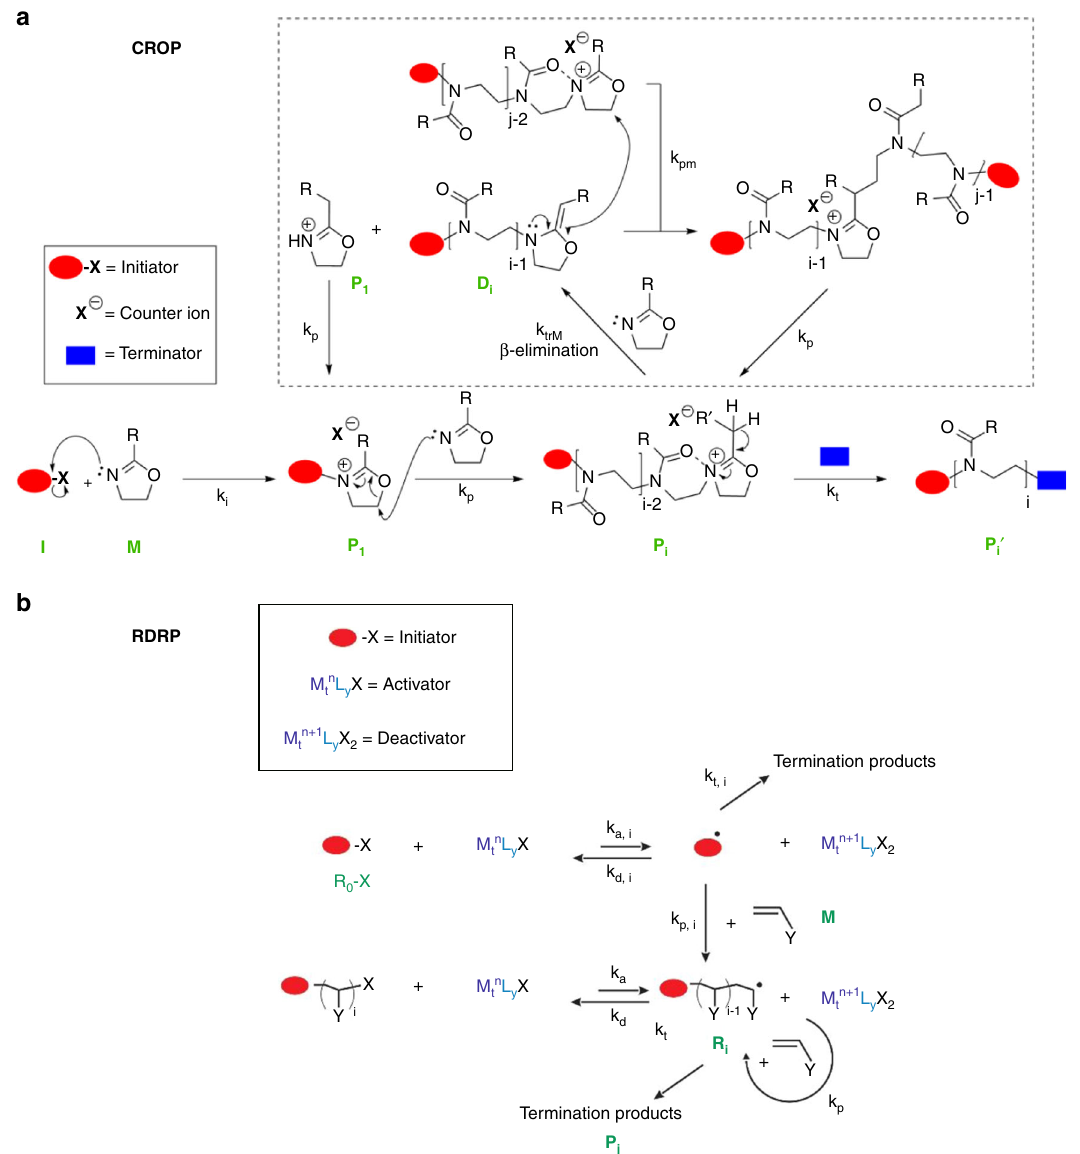
Fig. 1 Principle of cationic ring opening and reversible deactivation radical polymerization. a reactions for cationic ring opening polymerization (CROP) of 2- oxazolines (M) with initiator I; k i,p,t,trM,pm : rate coef fi cient of chain initiation leading to formation of P 1 , propagation leading to formation of P i (i: chain length; i > 1), termination leading to formation of P i ’ , β -elimination leading to formation of macromonomer D i , and macropropagation leading to formation of mid- chain cationic macrospecies with further propagation leading to branching; red oval: initiator part; X - : counter ion; blue box: terminating agent, e.g., methanolic sodium hydroxide; dashed box: side reactions; R: e.g., methyl. b reactions for atom transfer radical polymerization (ATRP), a key reversible deactivation radical polymerization (RDRP) technique, with vinyl monomer (M); k p,i,p,t(,i),a(,i),da(,i) : rate coef fi cient of chain initiation leading to formation of R 1 , propagation to R i , termination toward P i , activation, and deactivation with (,i) referring to the ATRP initiator R 0 X; X: end-group functionality;